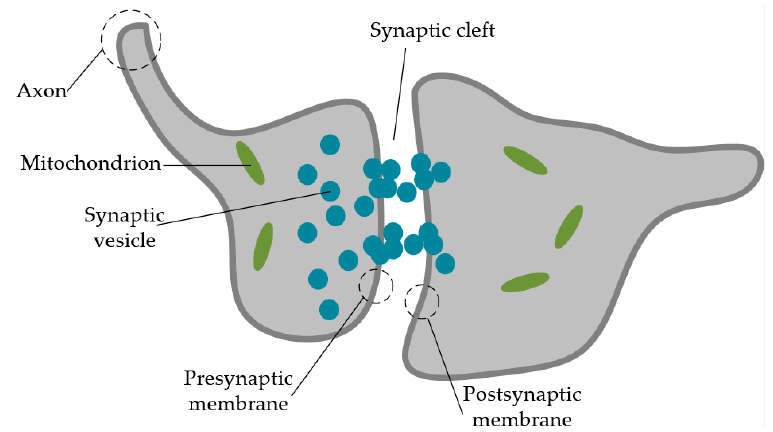
Figure 11. Structure of synapse in neural network.